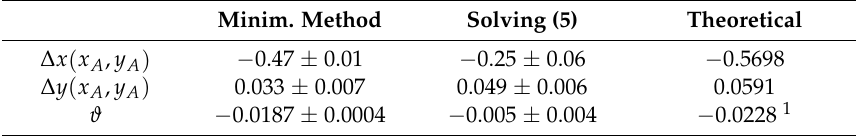
Table 1. Horizontal and vertical distances and torsional angle obtained from the location vector components computed using different methods for the experiment in Figure 9, and the theoretical values. Errors are obtained as standard deviation of the computed component of the last 50 frames of the sequence, when the system is static.